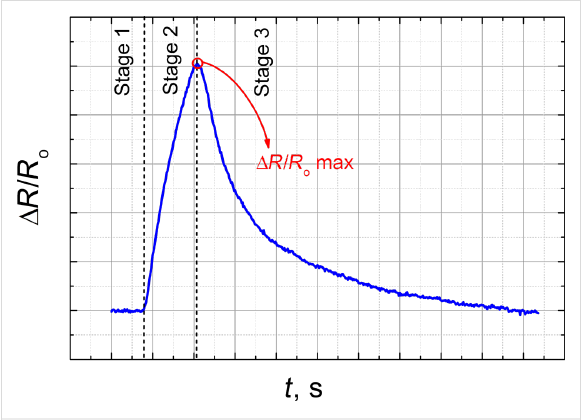
Figure 2: Expected relative change of the electrical resistance as a function of the time at different stages of the measurement. With the sensing effect we mean the peak of Δ R / R 0 max in the second